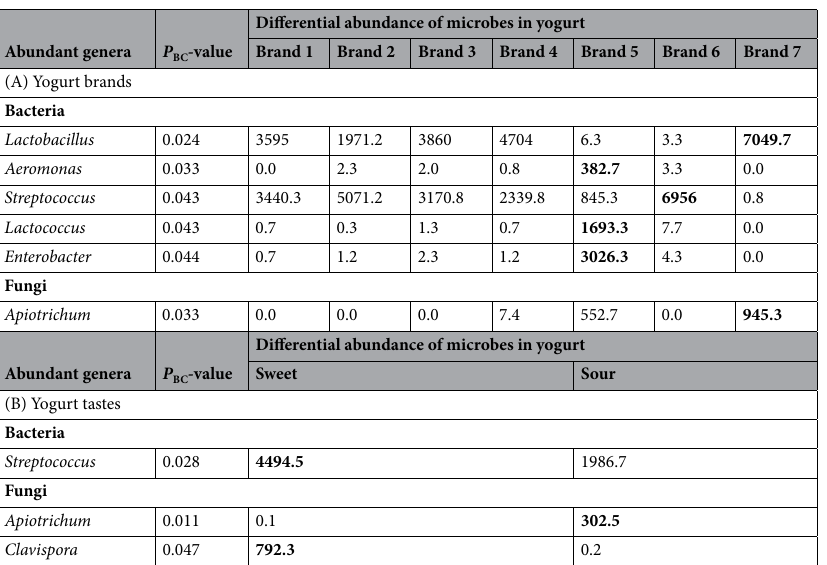
Table 3. Differential abundance of bacteria and fungi in Bangladeshi yogurt based on brands and tastes. The microbial genera with more than 1% read abundance are presented only. Differential abundances of bacteria and fungi were analyzed by Kruskal–Wallis test and shown as mean values. Boldface values indicate most abundant microbial genera. The Bonferroni corrected P -value ( P BC ) < 0.05 is considered significant. Differential abundance is expressed in number (n). Kruskal–Wallis test followed by Bonferroni correction was done for